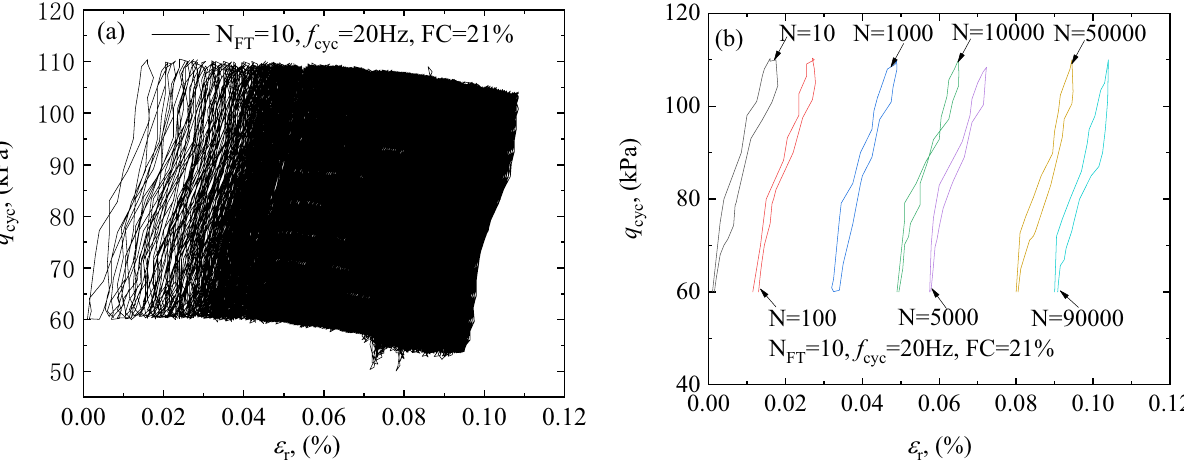
Figure 4. Hysteresis loop development characteristics: ( a ) hysteresis cycle of the sample under 90,000 loads, ( b ) hysteresis cycle of the sample under different